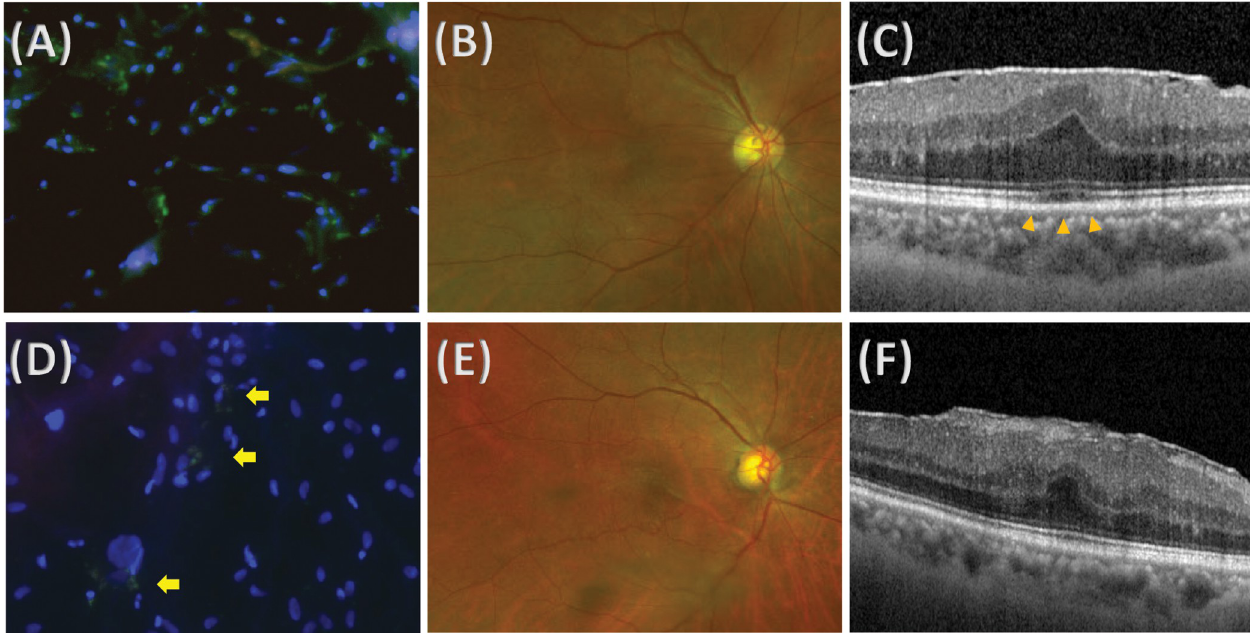
Fig 2. Representative images of stained epiretinal membrane (ERM) specimens and retinal images from patients with primary ERM with (A-C) or without (D-F) ellipsoid zone (EZ) defects. (A) Epiretinal membrane specimen from a 64-year-old female patient with primary ERM with EZ defect, showing higher positive staining for sphingosine-1-phosphate (S1P). (B) Ultrawide field retinal photograph that shows no specific underlying retinal disease. (C) Image of spectral-domain optical coherence tomography (SD-OCT) that shows ERM with EZ defect (arrowheads). (D) Epiretinal membrane specimen from a 73-year- old female patient with primary ERM without EZ defect, showing lower positive staining for S1P. Only a couple of cells were stained with S1P (arrows). (E) Ultrawide field retinal photography that shows no specific underlying retinal disease. (F) Image of SD-OCT that shows ERM without EZ defect.